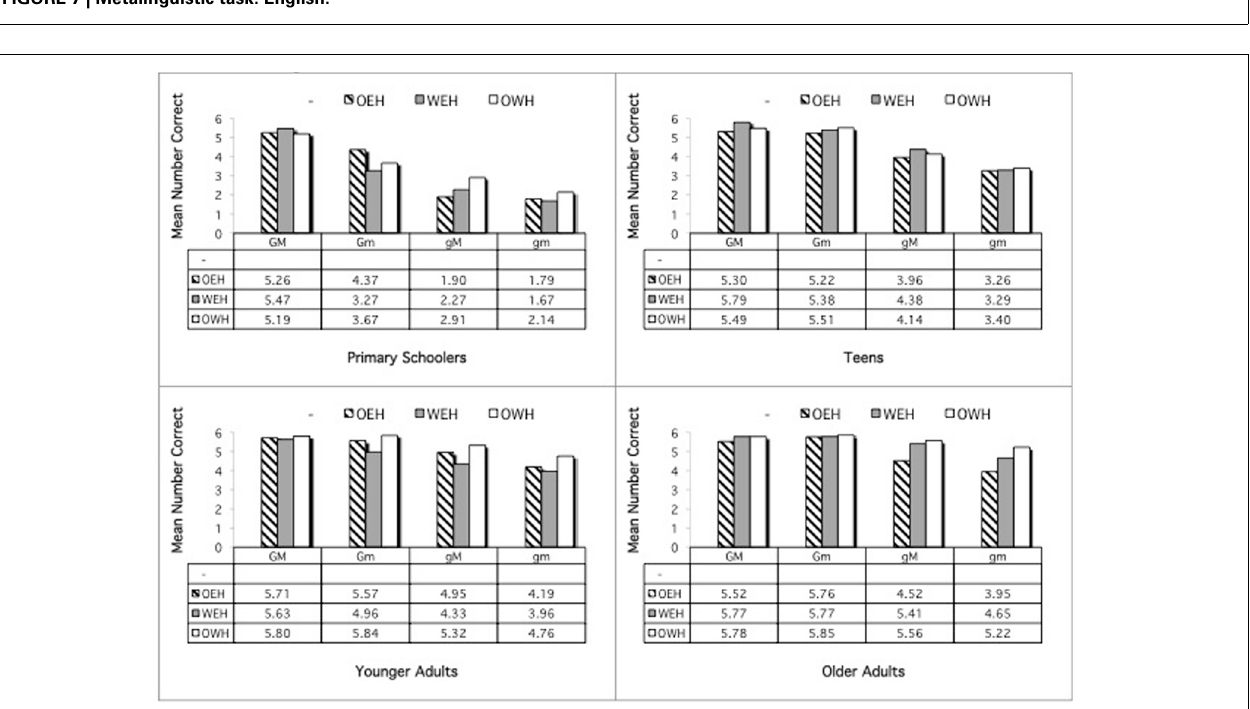
FIGURE 8 | Metalinguistic task: Welsh.